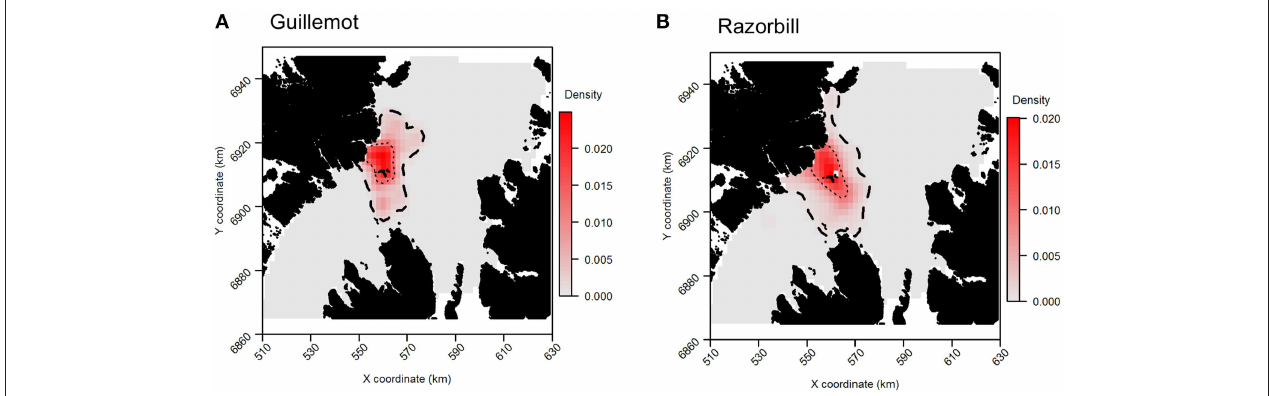
FIGURE 11 | Guillemot (A) and Razorbill (B) utilization distributions from GPS data collected only during times when boat surveys were being carried out. Darker reds indicate higher probability densities. Thick, dashed line indicates extent of 95% home range; thin, dotted line indicates extent of 50% home range.